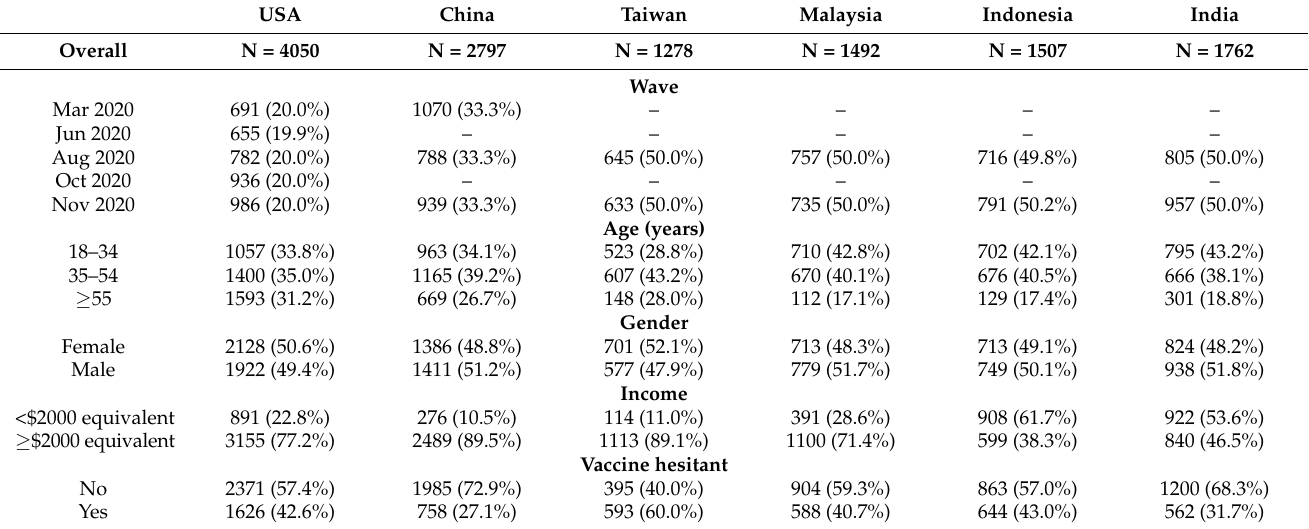
Table 1. Demographic characteristics of study